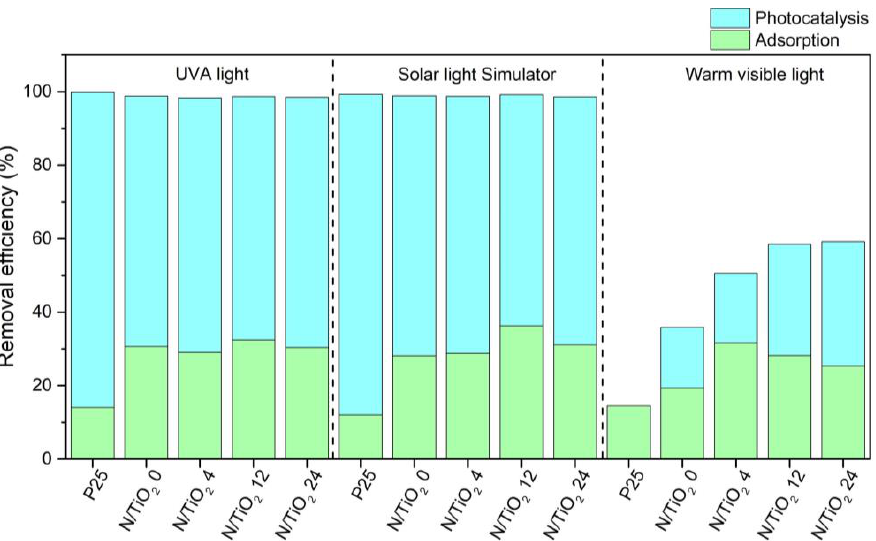
Figure 9. CIP removal efficiencies by Degussa P25 TiO 2 and N/TiO 2 materials under UVA light (lamp I), Solar light simulator lamp (II), and warm visible light (lamp III).